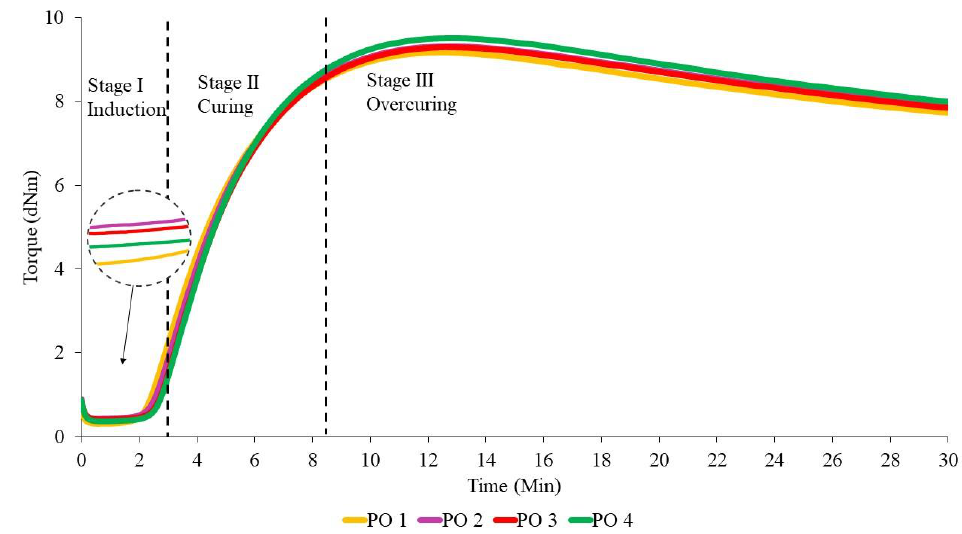
7 of 22 Figure 2. The curing curves of NR-based MREs for different ratios of LMO:AO. Figure 3 depicts the curing curves for different ratios of PO:AO. Similar to NO:AO and LMO:AO ratios, all MRE samples using PO:AO exhibited reversion behavior after 15 min of the curing process. Increased reversion behavior was observed when the PO was mixed with high amounts of AO in the NR compounds. The reversion percentage of PO 2 was the lowest compared to PO 1, PO 3, and PO 4. This was due to the breakdown of